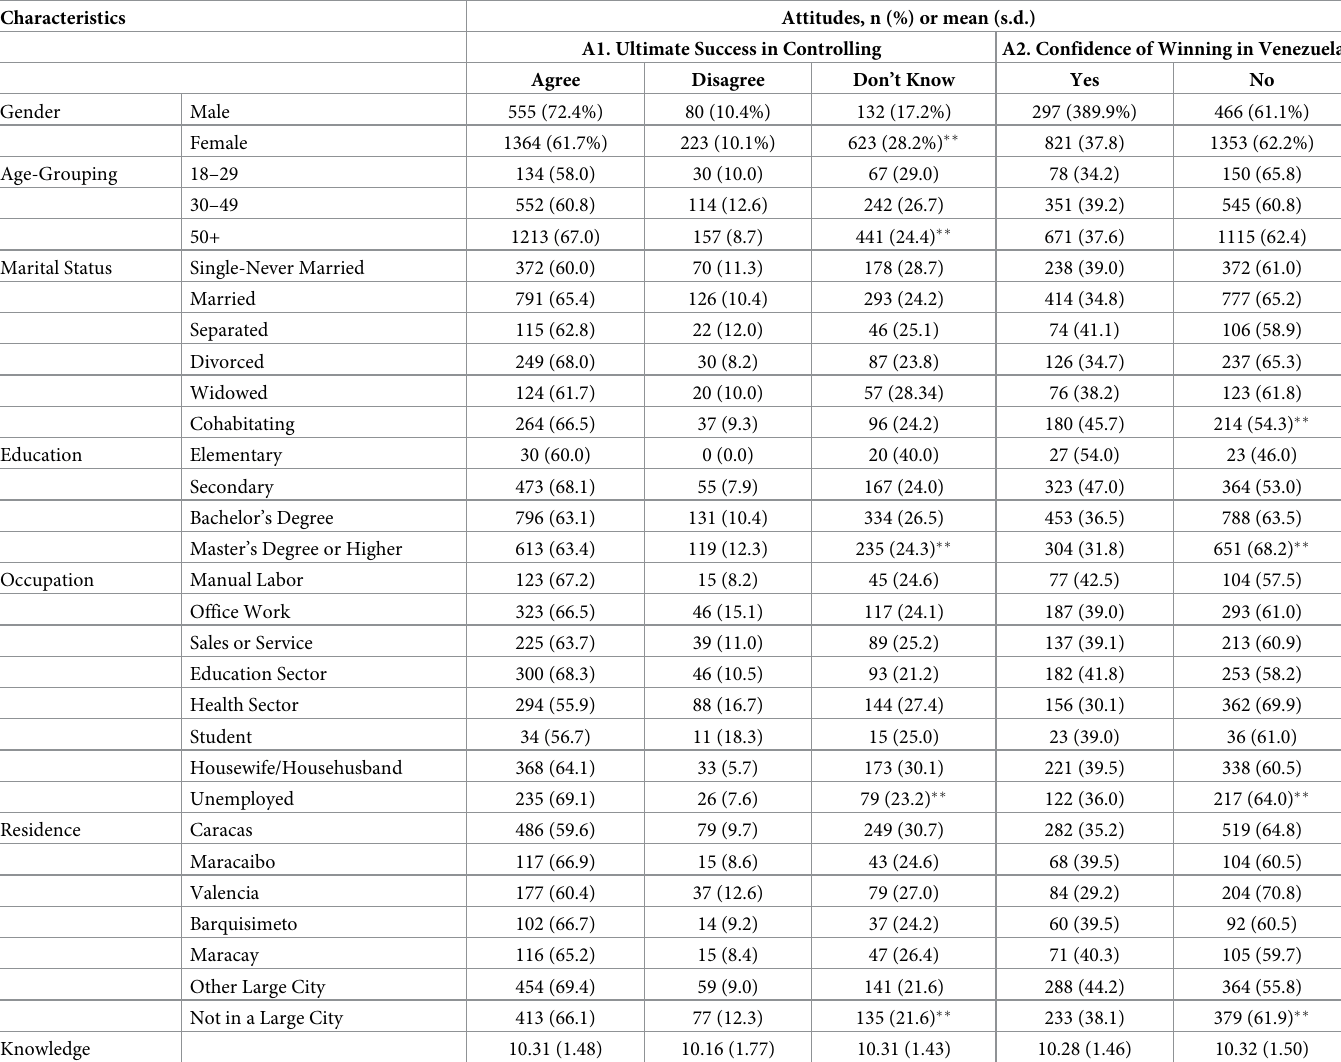
Table 3. Attitudes towards COVID-19 by demographic